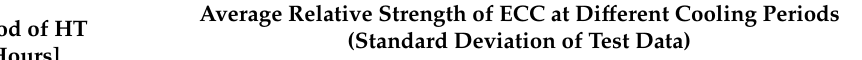
Table 8. Average relative strength of BF-reinforced ECC specimens at di ff erent periods of HT (based on Table